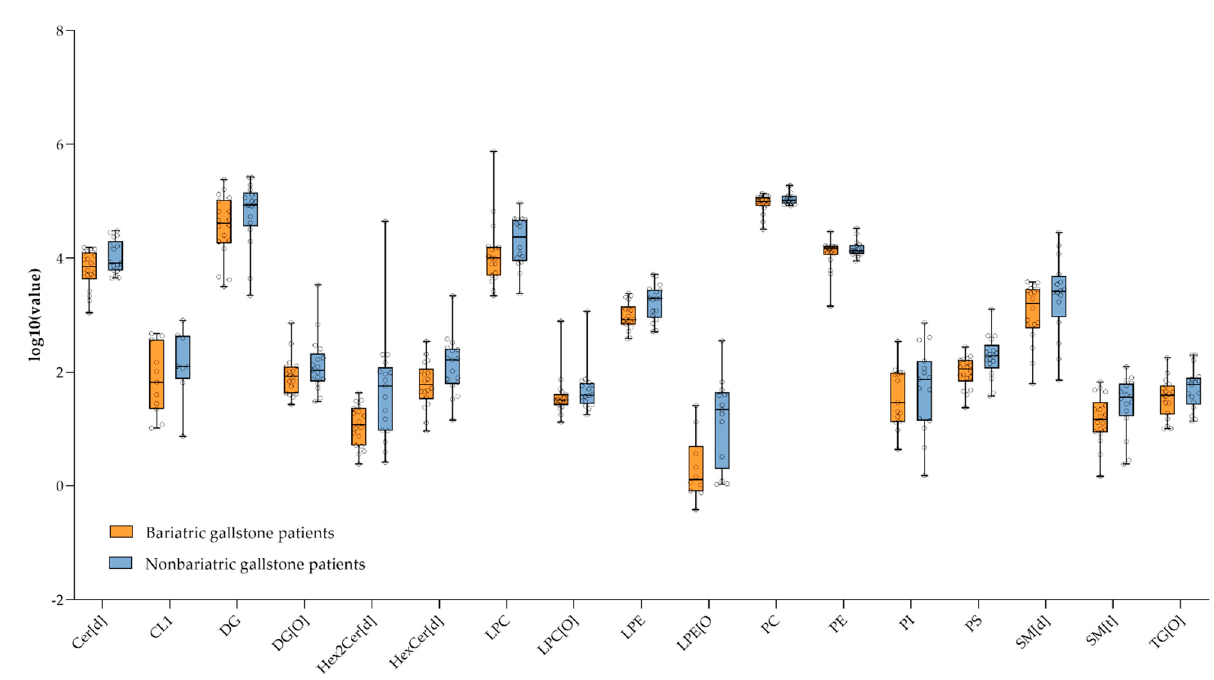
Figure 2. Logarithm-transformed total lipid levels in gallbladder bile sorted by lipid class that did not significantly differ between the groups. Total levels are defined as the ratio between the abundance of all lipid species of the same class and the abundance of the corresponding internal standard. Cer[d], ceramide; CL1, cardiolipin; DG, diglyceride; DG[O], alkyl-diglyceride; Hex2Cer[d], dihexosylceramide; HexCer[d], hexosylceramide; LPC, lyso-phosphatidylcholine; LPC[O], (lyso)alkyl-phosphatidylcholine; LPE, lyso-phosphatidylethanolamine; LPE[O], (lyso)alkyl-phosphatidylethanolamine; PC, phosphatidylcholine; PE, phosphatidylethanolamine; PI, phosphatidylinositol; PS, phosphatidylserine; SM[d], sphin- gomyelin; SM[t], hydroxysphingomyelin; and TG[O], alkyl-triglyceride.